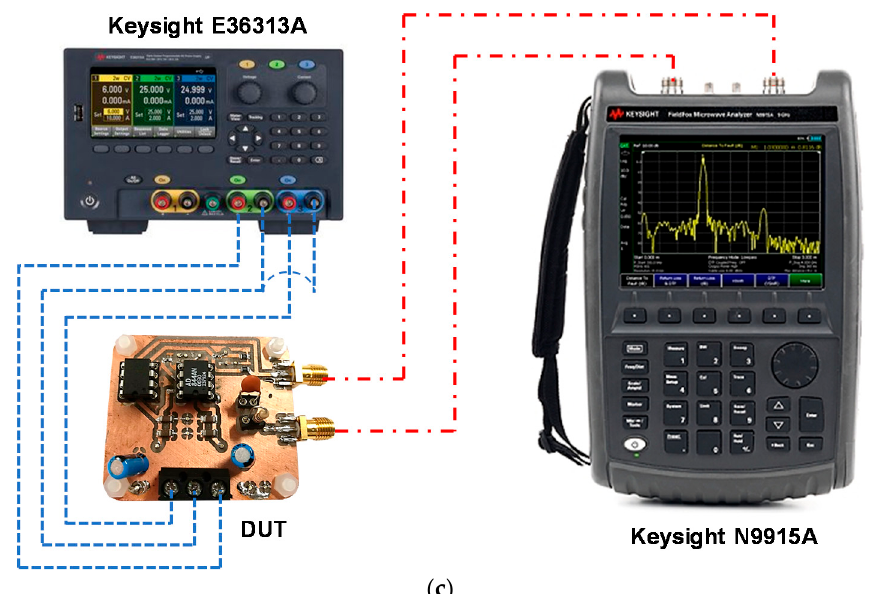
Figure 11. ( a ) Final prototype board; test benches: ( b ) for time domain measurements; ( c ) for frequency domain measurements.